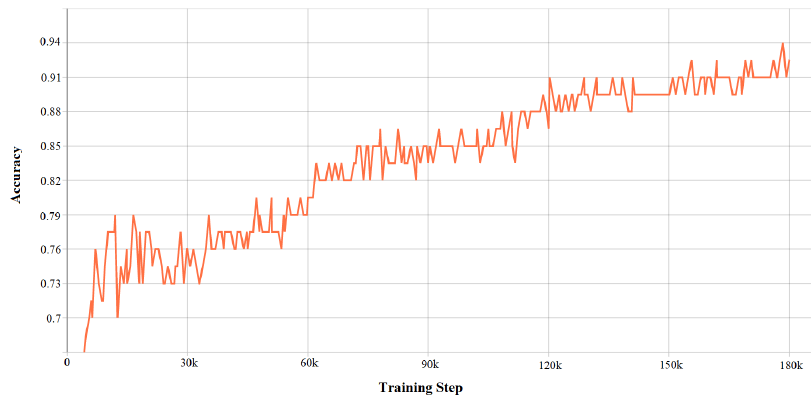
Figure 18. Characteristics of DDQN hyper-parameters: accuracy